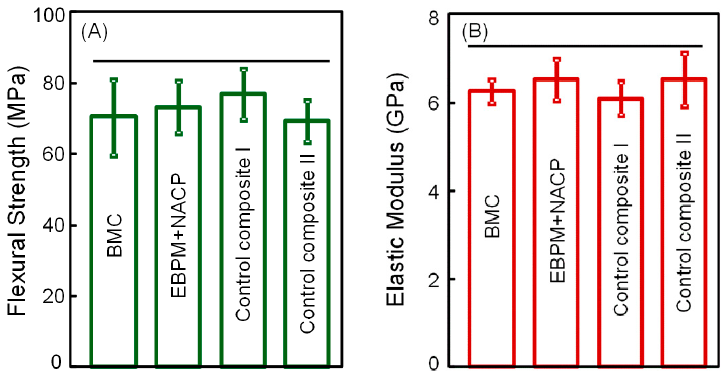
Figure 1. Mechanical properties of composites: ( A ) Flexural strength, and ( B ) elastic modulus (mean ± SD; n = 6). Bioactive multifunctional composite (BMC) had flexural strength and elastic modulus similar to EBPADMA-PMDGDM (EBPM) + nanoparticles of amorphous calcium phosphate (NACP) composite and commercial control composites. Horizontal line indicates values that are not significantly different ( p =